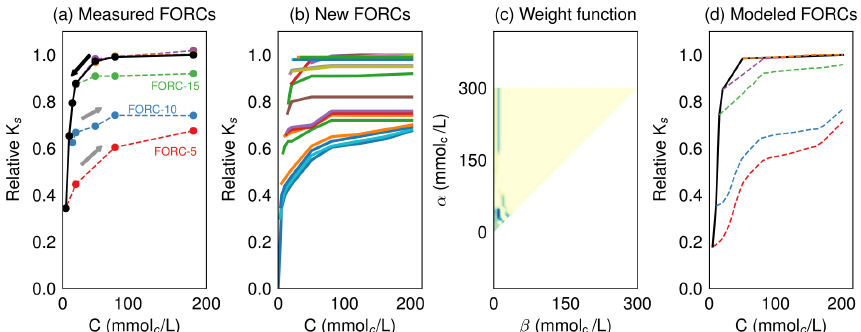
Figure B1. Experimental results (a) can be augmented by interpolated FORCs (b) , resulting in a finer weight function (c) , which, in turn, can reproduce the initial data more faithfully (d) . This exercise demonstrates that increasing the number of experimental points will yield more accurate predictions, exemplifying the well-known tradeoff between resource expenditures (more data) and